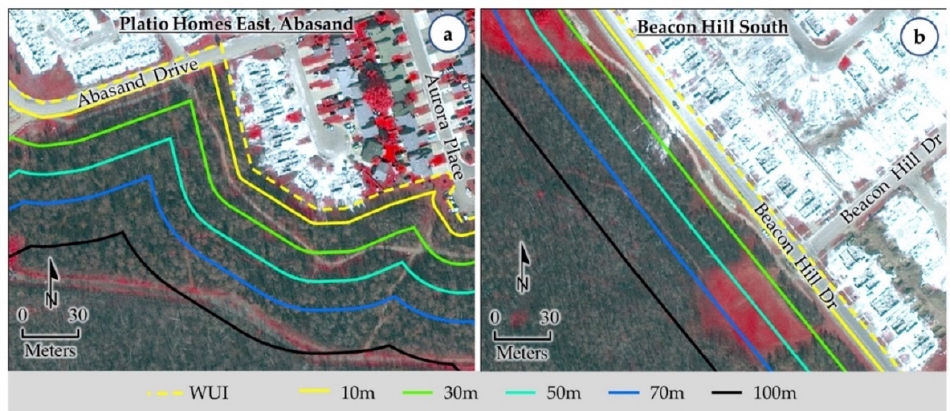
Figure 3. Existence of forest within the 10–30 m from the WUI, where the blackish tone indicates burned forest near the Abasand ( a ), and Beacon Hill ( b ) communities. (Source: ©Ahmed et al. 2018 licensed under CC BY.).